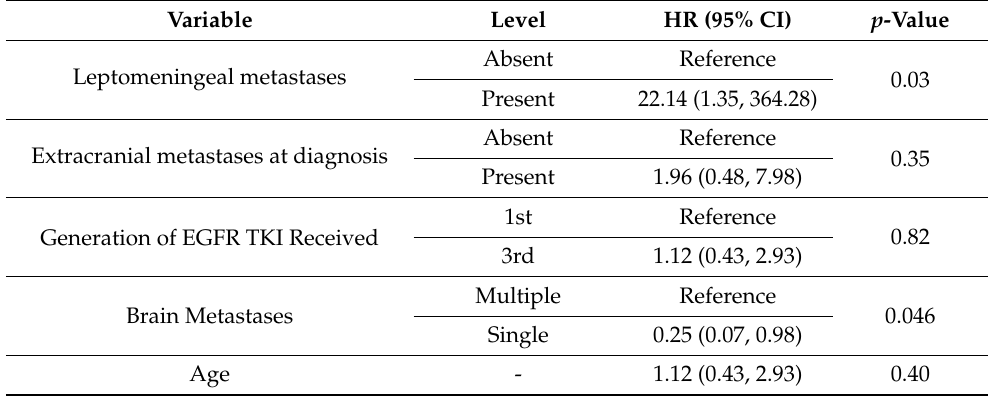
Table 11. Multivariable Cox-Proportional Hazards Modelling of progression-free survival for EGFR- altered NSCLC patients with brain metastases in 2nd-to-5th-line EGFR-TKI.